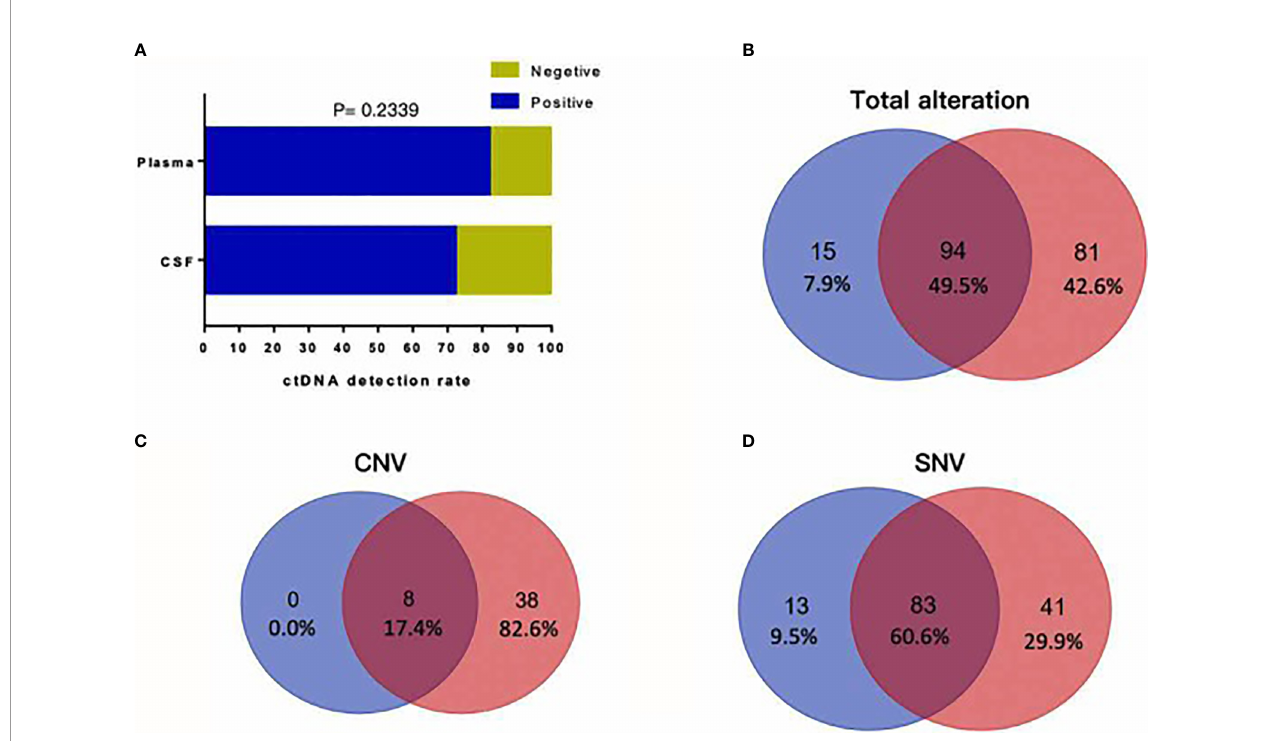
FIGURE 2 | (A) cfDNA positive in 52 samples of CSF and in 59 samples of plasma, and the detection rate of cfDNA is not statistically different in CSF and plasma ( p = 0.2339). (B) For detection of genomic alterations, 94 could be detected in both plasma and CSF. However, 81 can be detected in CSF but cannot be found in plasma, while 15 can be found in plasma which cannot be detected in CSF. (C) For CNV, eight alterations can be detected both in plasma and CSF and 46 alterations can be found in CSF. (D) For SNV, 83 alterations can be found both in CSF and plasma, while 41 can be detected in CSF and 13 in